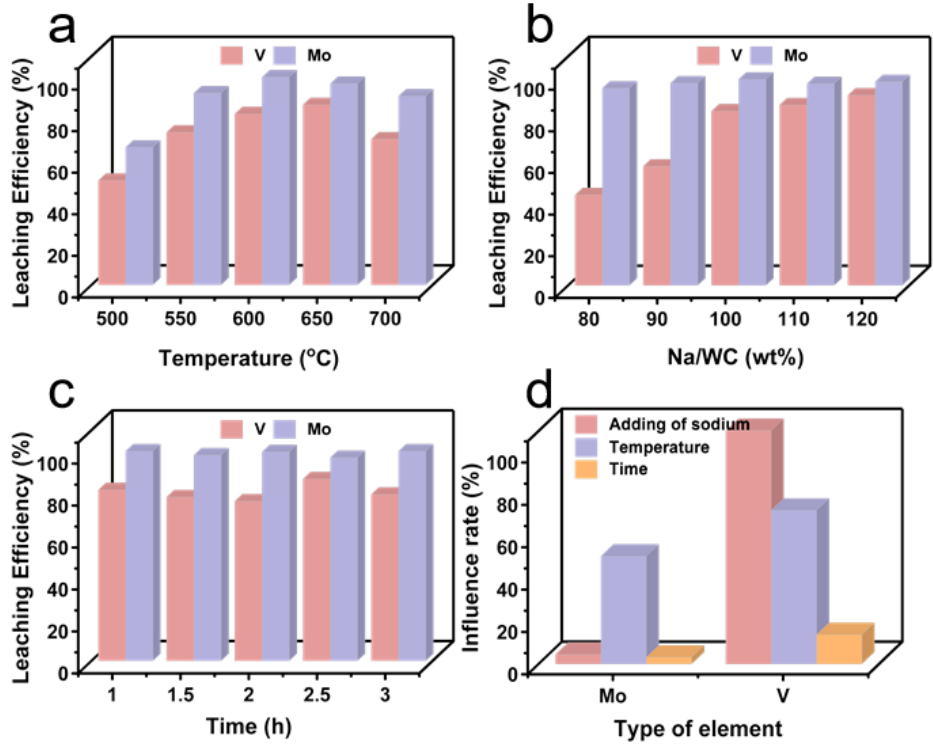
Figure 3. Effects of roasting conditions of sodium salt on leaching efficiency of the metal elements in the waste HDS catalyst, ( a ) temperature, ( b ) Na/WC mass ratio, ( c ) time. And ( d ) the influence rate of roasting conditions on leaching efficiency of metal